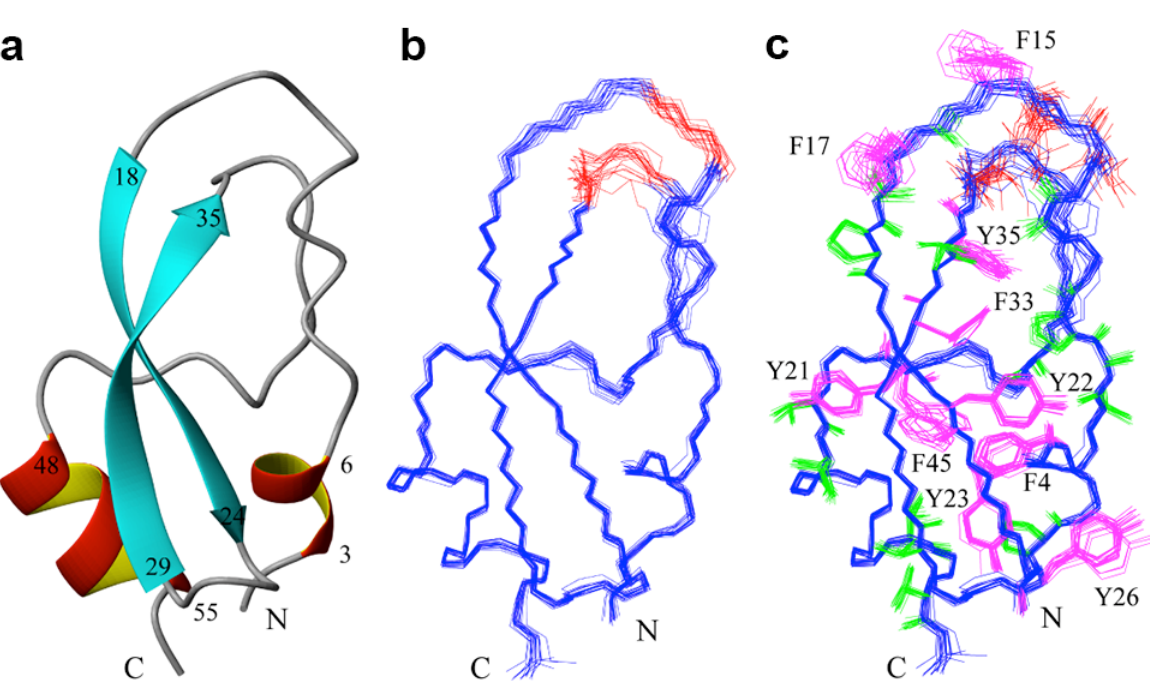
Figure 2. NMR solution structure of NACI. ( a ) Ribbon diagram of NACI. ( b ) Superposition of the backbone atoms of the 20 conformers that represent the solution structure of NACI for best fit of the backbone atoms N, C α , C’ in the secondary structure regions, residues 3–6, 18–24, 29–35, and 48–55. Residues Ser13–Cys14 and Ser36–Cys38 around the Cys14–Cys38 disulfide bond are not well defined due to missing resonances and indicated in red. ( c ) Side chains of Ser13–Cys14 and Ser36–Cys38 are shown in red, aromatic residues (F4, F15, F17, Y21, Y22, Y23, Y26, F33, Y35, F45) in magenta, and hydrophobic residues (Ala, Val, Leu, Ile, Thr, Pro) in